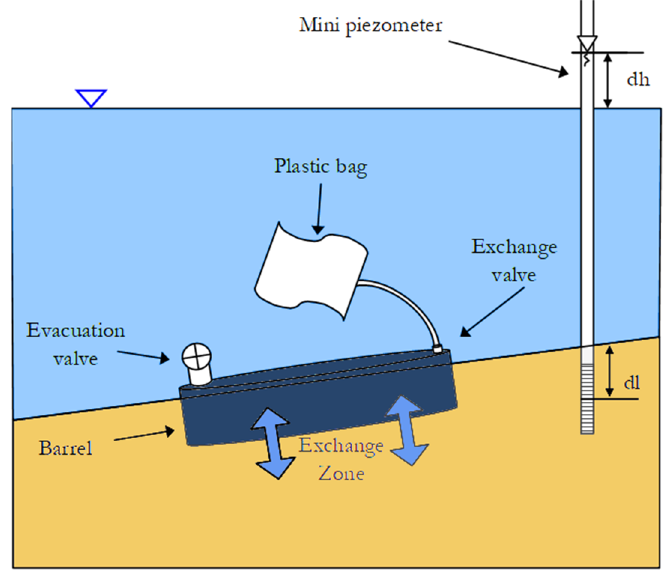
Figure 4. Schematic of the seepage meter device.